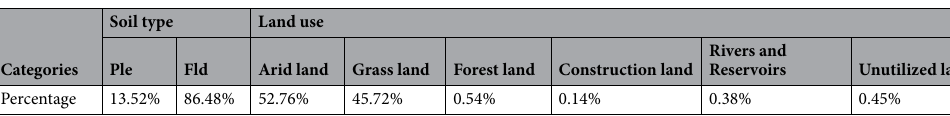
Table 2. Soil and land use types in the study area.